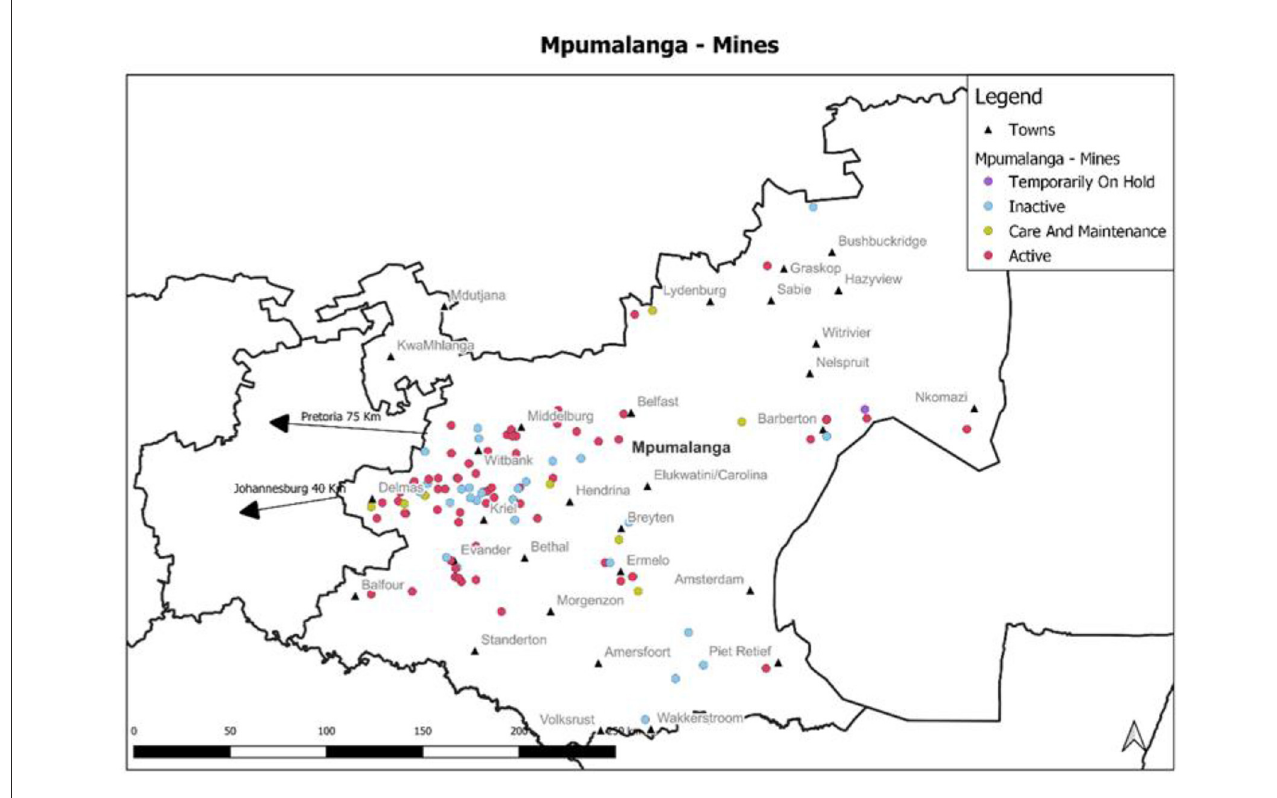
FIGURE3 Mines in Mpumalanga by nature of their operational status,